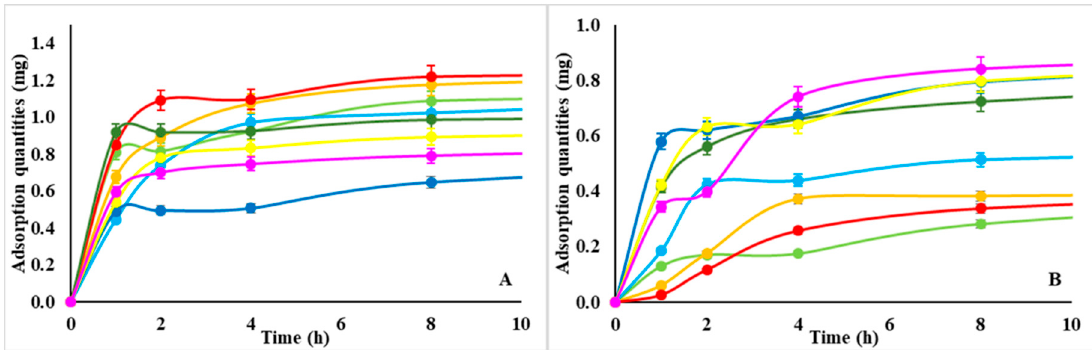
Figure 3. NMP adsorption trend—adsorbed milligrams of protein by d-NMP ( A ) and w-NMP ( B ). Lysozyme: CM-dextran in light green, hyaluronic acid in light blue, alginate in orange, and dextran in red. BSA: CM-dextran in dark green, hyaluronic acid in blue, alginate in yellow, and dextran in pink.